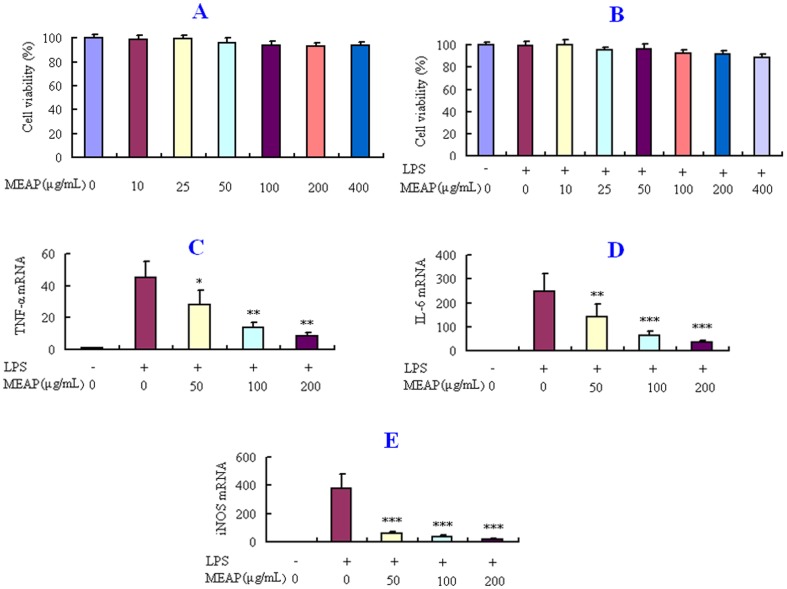
Effects of MEAP on TNF-α, IL-6, and iNOS mRNA expression in RAW 264.7 cells induced by LPS (100 ng/mL).TNF-α, IL-6, and iNOS mRNA expression levels were normalized by β-actin, and fold changes in mRNA expression are shown as the mean ± SEM (n = 4). *P<0.05, **P<0.01, ***P<0.001, compared with LPS alone.